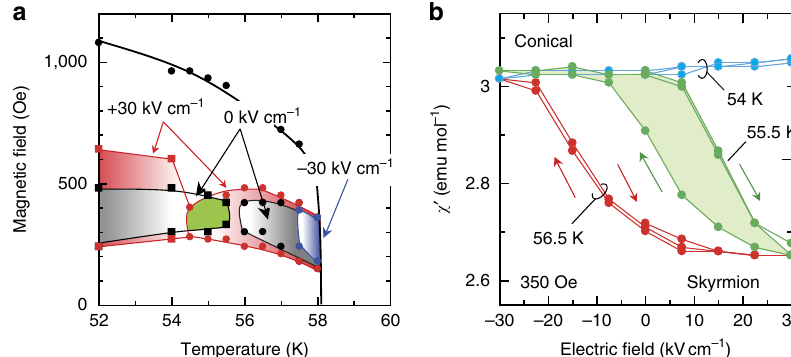
Figure 4 | Non-volatile switching between the skyrmion and conical phases using electric fields. ( a ), Superposed phase diagrams measured under different electric fields; þ 30, 0, (cid:2) 30kVcm (cid:2) 1 . The green-hatched region represents the temperature/magnetic field region in which non-volatile switching of the skyrmion phase is possible using electric fields. Red-, black- and blue-coloured regions represent (thermodynamically stable or metastable) skyrmion lattice states under þ 30, 0 and (cid:2) 30kVcm (cid:2) 1 , respectively. The green-hatched region highlights the region where the thermodynamically stable (at þ 30kVcm (cid:2) 1 ), metastable (at 0kVcm (cid:2) 1 ), and unstable (at (cid:2) 30kVcm (cid:2) 1 ) skyrmion lattice are all realized. ( b ), The w ’ – E profiles at 54, 55.5, and 56.5K at 350Oe. The hysteresis loop at 55.5K is highlighted in green, representing the non-volatile switching between conical (high w ’ ) and skyrmion (low w ’